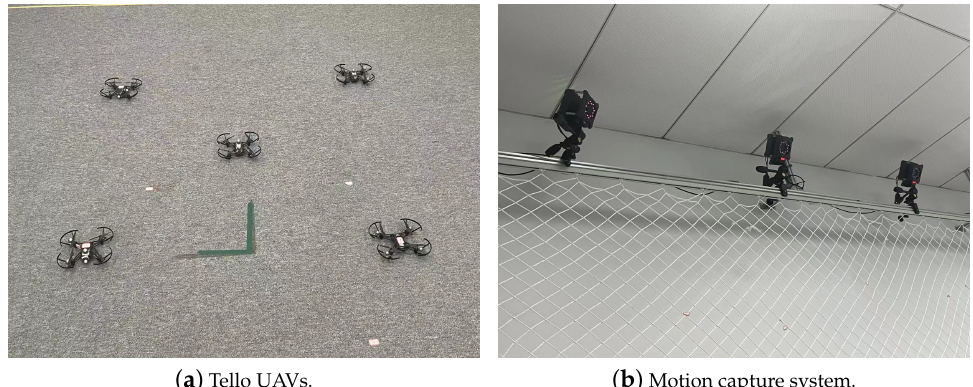
( a ) Tello UAVs. ( b ) Motion capture system. Figure 9. Formation tracking experimental